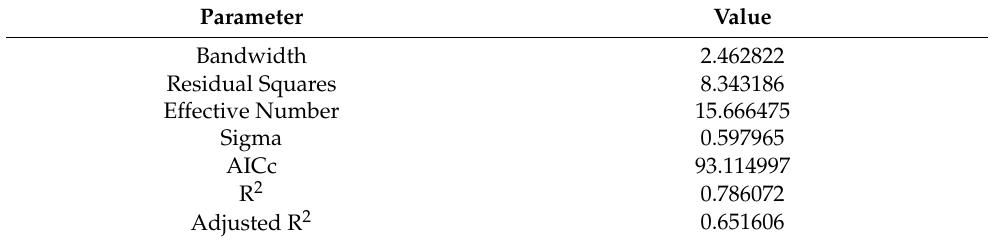
Table 5. Parameter estimation and test results of the GWR model.